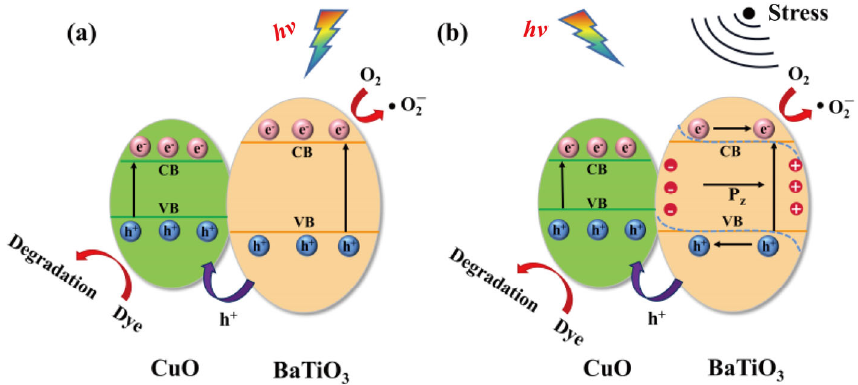
Fig. 9 (a) Proposed photocatalytic and (b) piezo-photocatalytic degradation mechanisms of BaTiO 3 /CuO hybrid